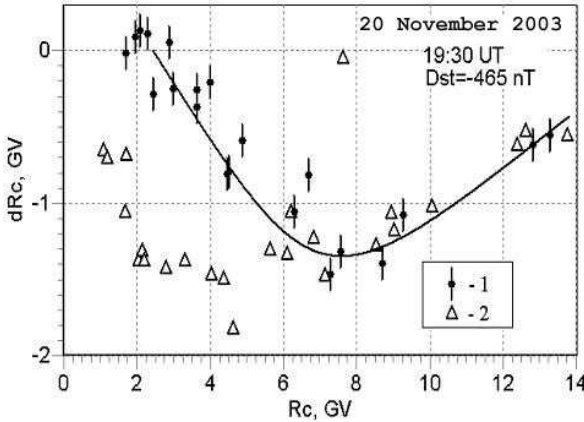
Figure 2. Cutoff rigidity variation (dRc) vs. the cutoff rigidity (Rc) at the peak of magnetic storm on 20 November 2003. Dots (1) indicate the points with error limits obtained by the global survey method applied to the data of the worldwide neutron monitor network. Triangles (2) mark the results of CR trajectory calculations with using the T01S model. Note the deviation of both experimental and model points for the Mexico station from the smooth variation dRc(Rc ) .